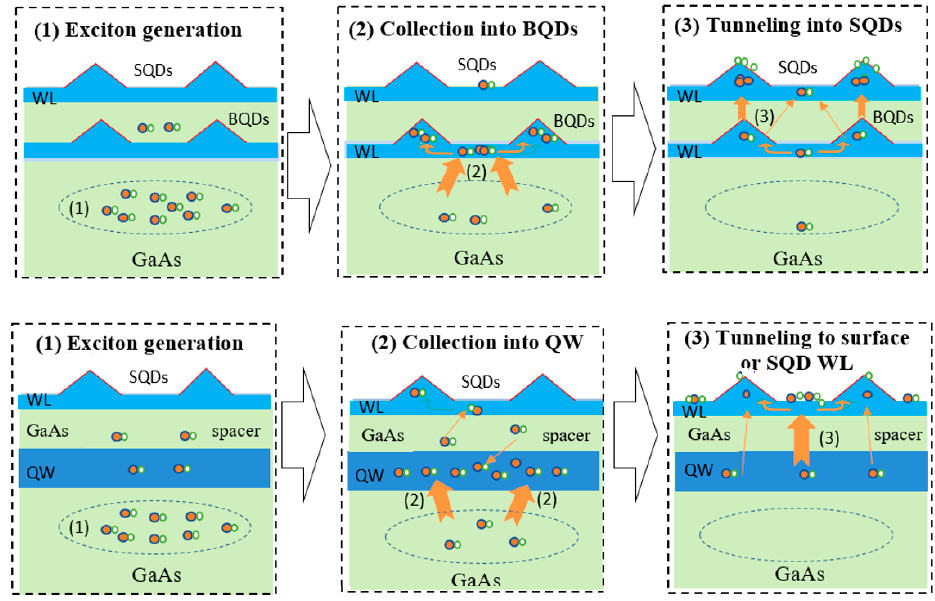
Figure 4. Demonstration of the carrier dynamics in samples A and B, including ( 1 ) exciton generation inside GaAs matrix, ( 2 ) relaxation into BQDs or QW, and finally, ( 3 ) tunneling into SQDs in sample A, or into SQD WL and then lost to the surface in sample B.